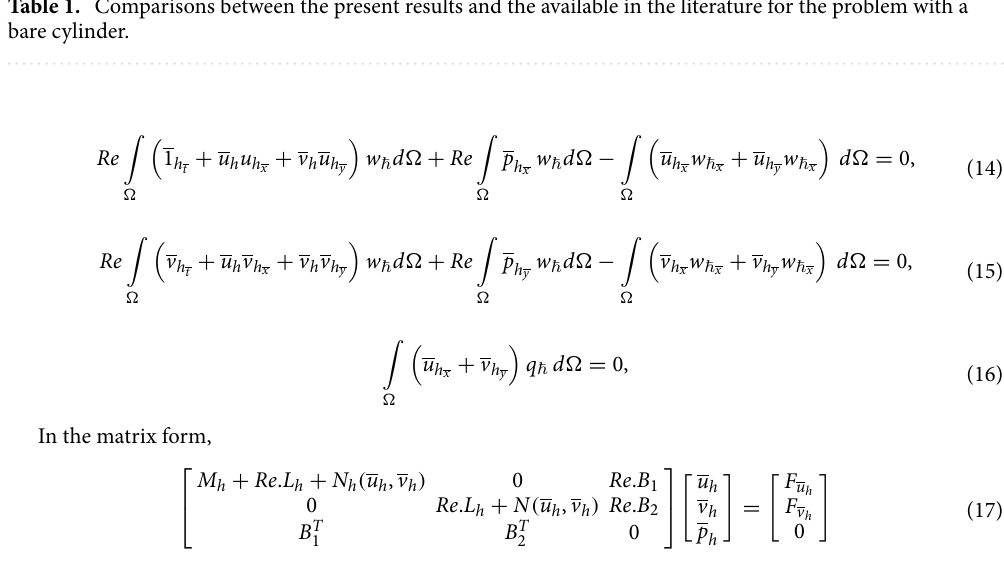
Research Maximum of C D Present